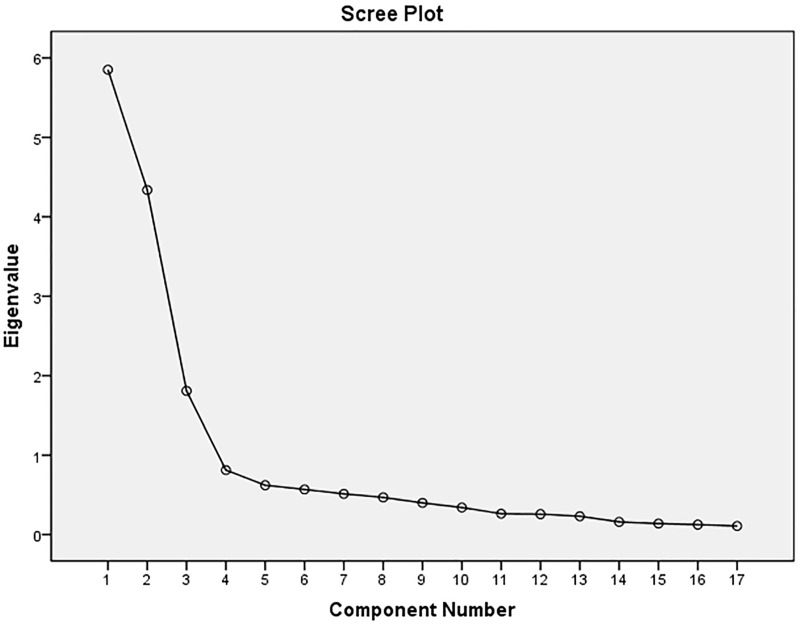
Scree Plot of SASE-CHI (n = 576).Note. SASE-CHI: the Chinese version of Self-care Ability Scale for the Elderly.